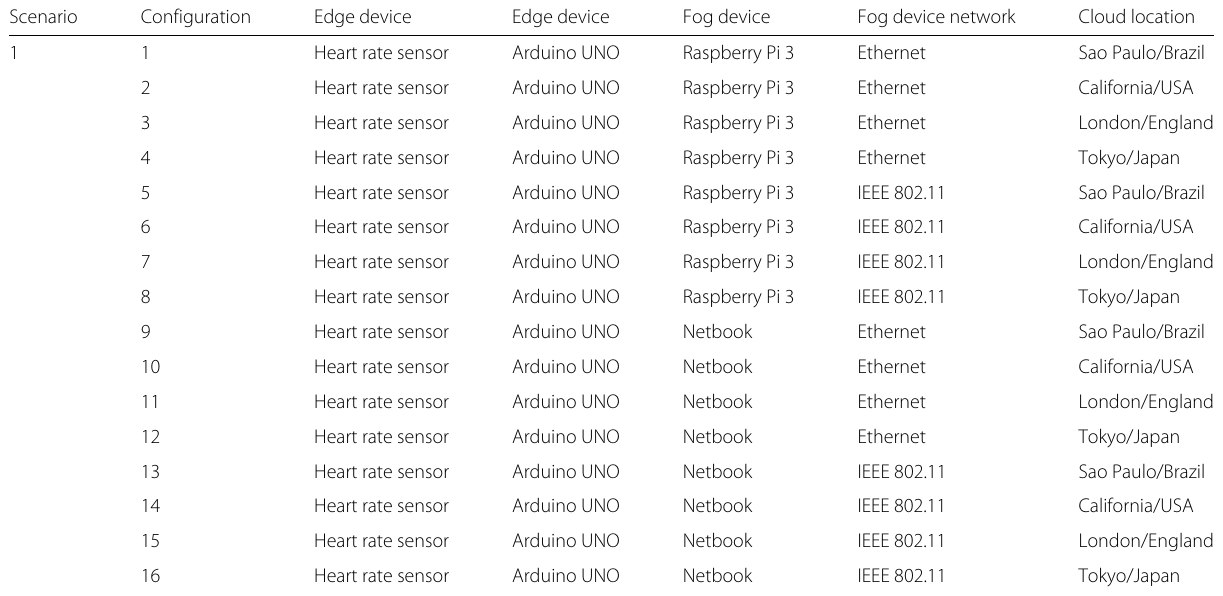
Table 5 Component configurations of scenario 1 Scenario